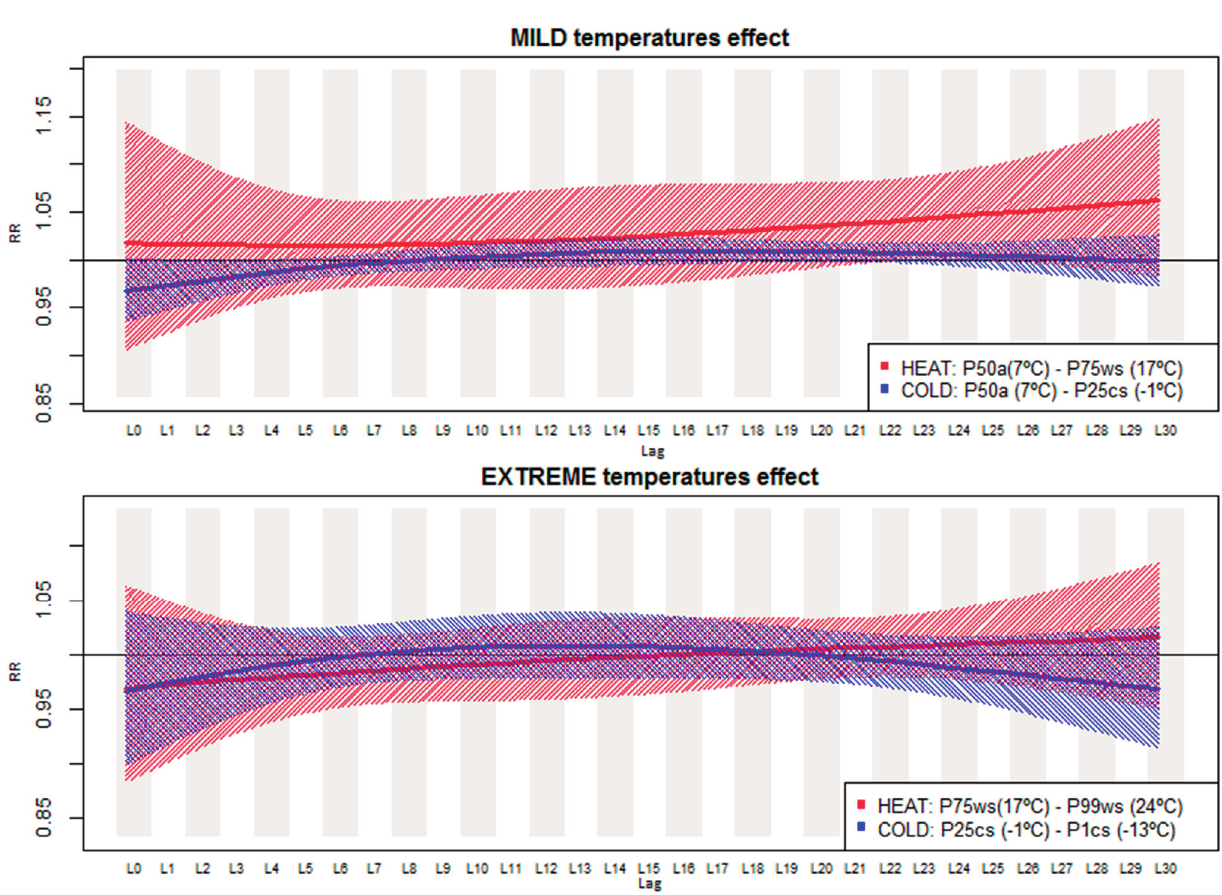
Figure 2. Lag-specific risk ratios (RR) and 95% confidence interval of the effect of moderate mild (top) and extreme (bottom) heat and cold up to 30 days after the exposure (a: defined percentile of the annual mean temperature distribution; CS/WS: defined percentile of mean temperature distribution in the cold or warm